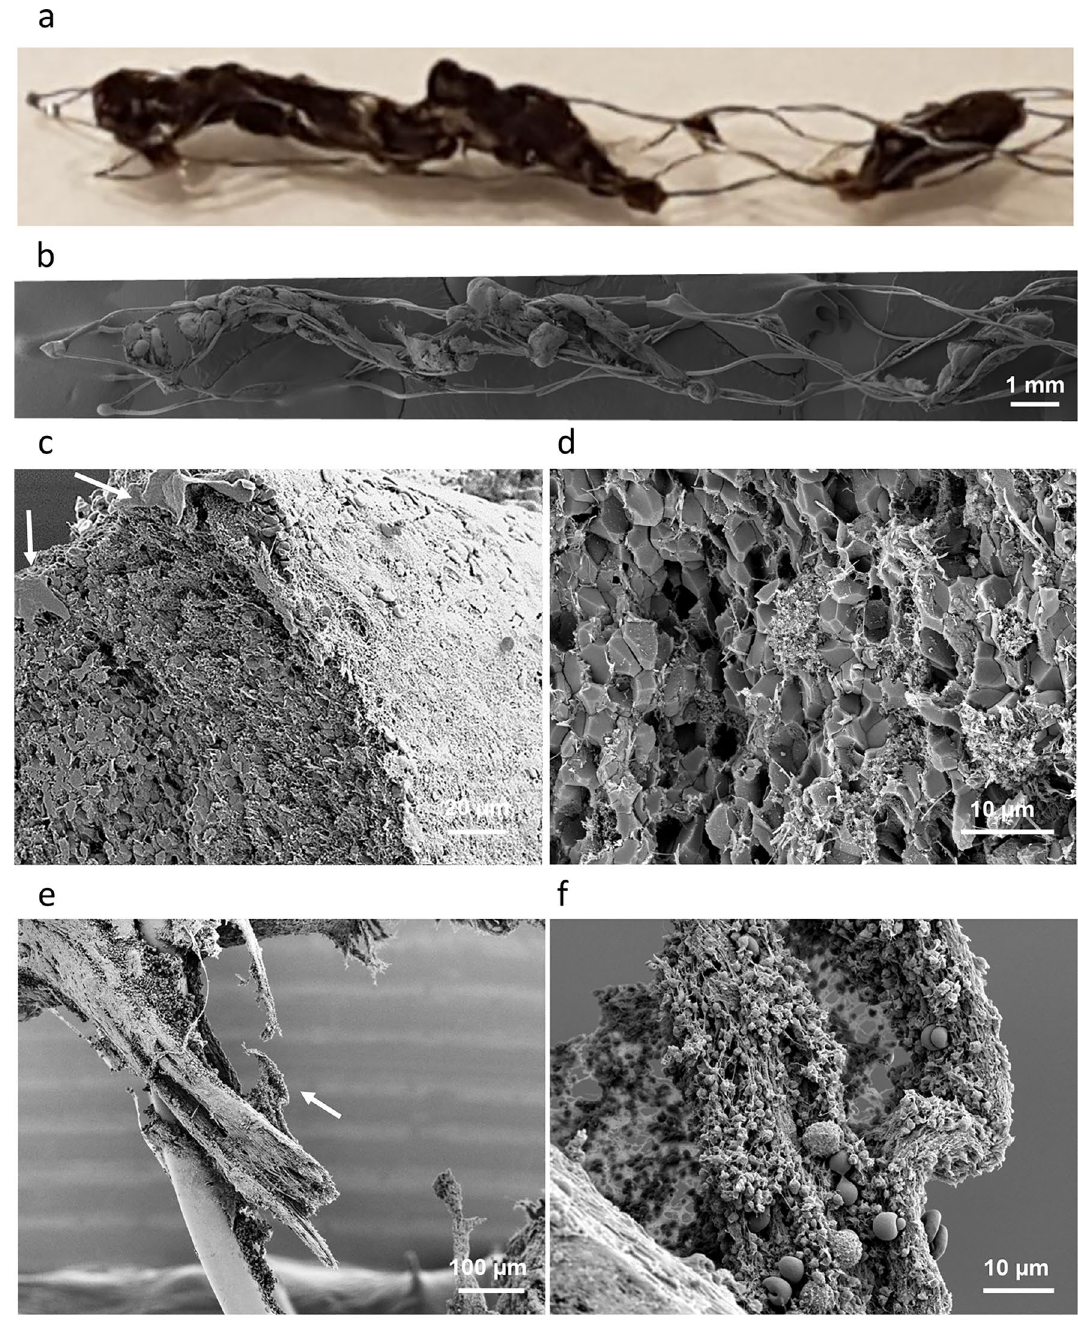
Figure 1. RBCs rich thrombus incorporated onto the stent retriever (Case 2 in Table 1). ( a ) Optical micrograph. ( b ) Collage of SEM micrographs. ( c ) Cross section of a thrombus segment, showing a compact core, porous periphery and fibrin outer layer. Remnants of vascular tissue are visible at the thrombus surface (arrows). ( d ) High magnification view of the compact core composed of polyhedrocites. ( e ) Fibrin strings are found in between thrombus segments. ( f ) White blood cells and platelets are attached to the fibrin strings (higher magnification view of ( e ), region marked with